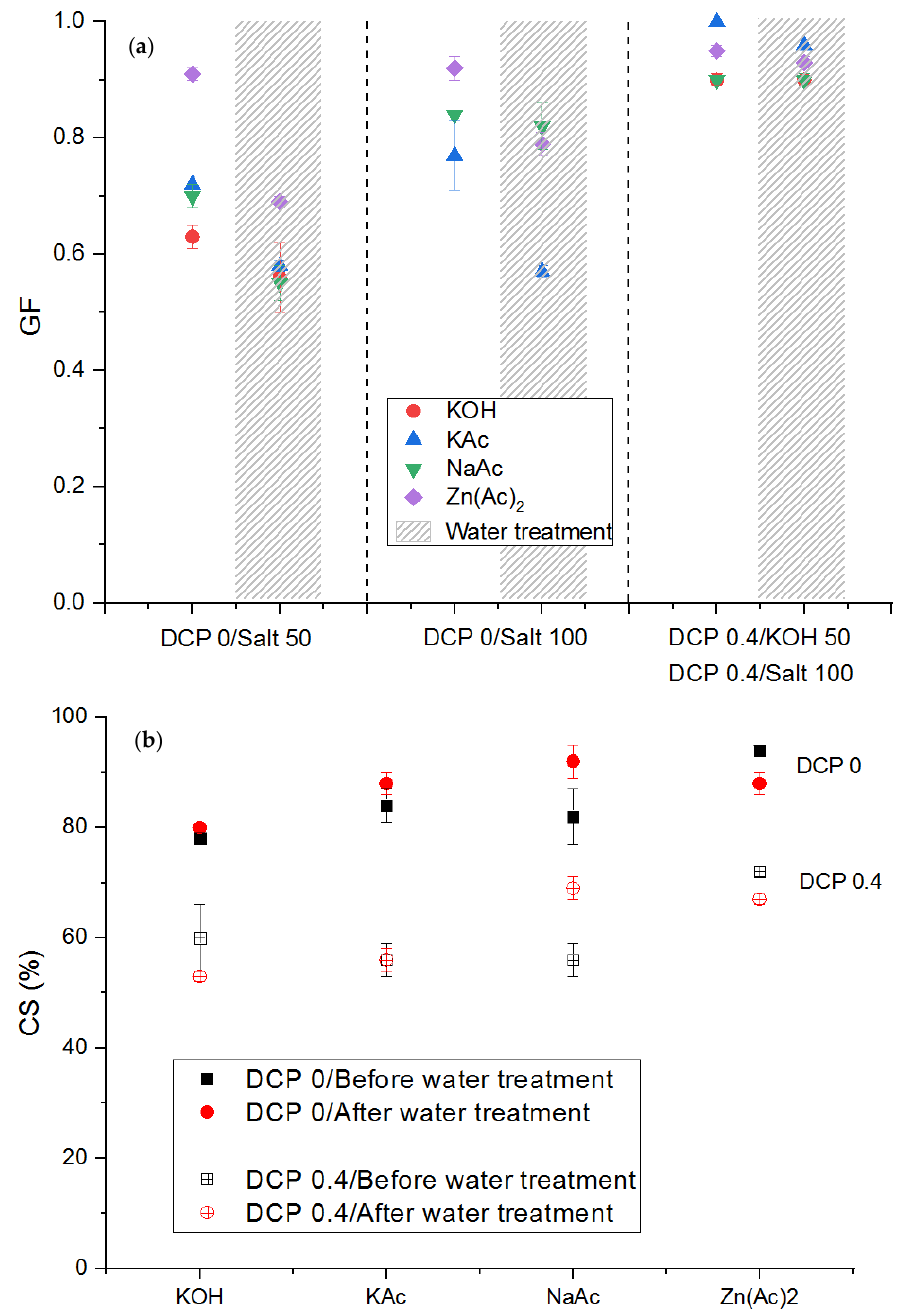
Figure 10. Variation of the gel fraction ( a ) and the compression set ( b ) of EPDM-g-MA crosslinked with different ions (KOH, KAc, NaAc, and ZnAc 2 ) and with the combination of both ionic and covalent networks. Influence of the water treatment.